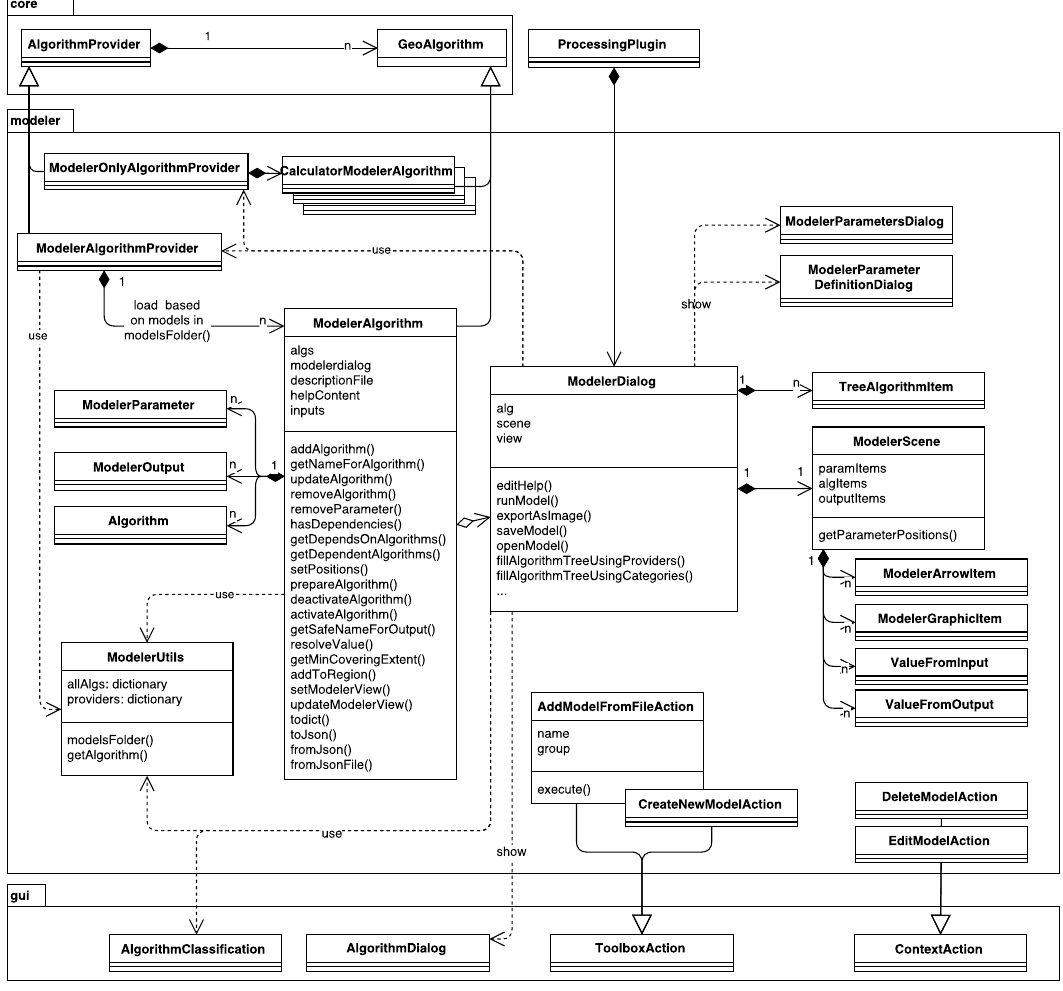
Figure 4. Class diagram of the modeler package and its connections to other packages.